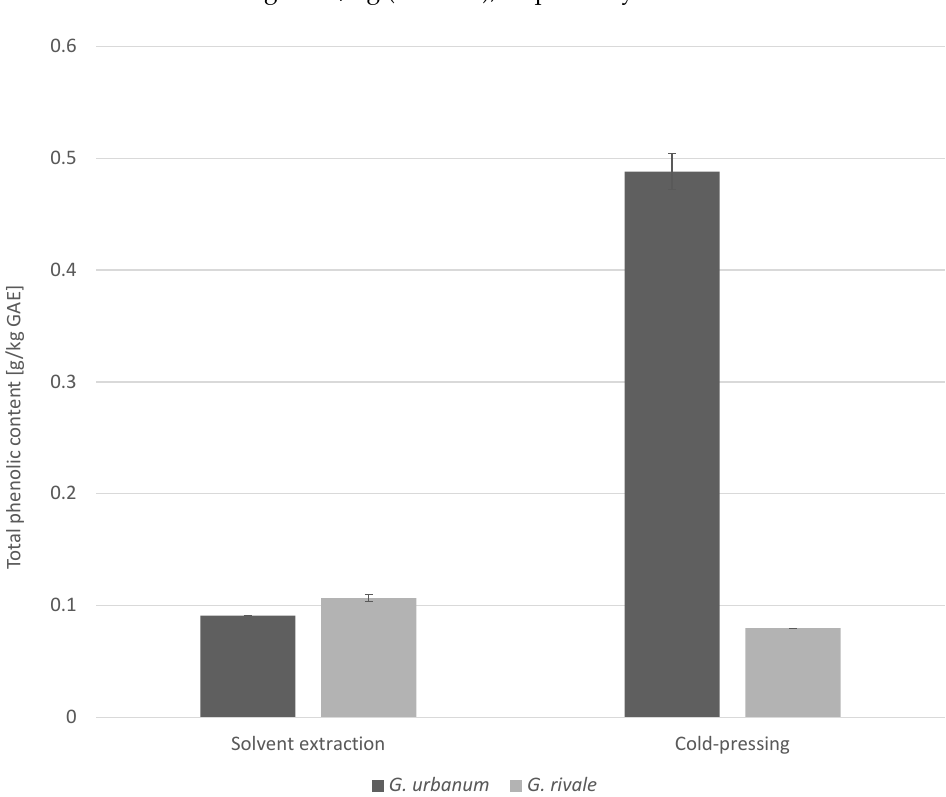
Figure 5. Determination of total phenolic contents of G. urbanum and G. rivale seed oils using the Folin–Ciocâlteu assay ( n = 3).